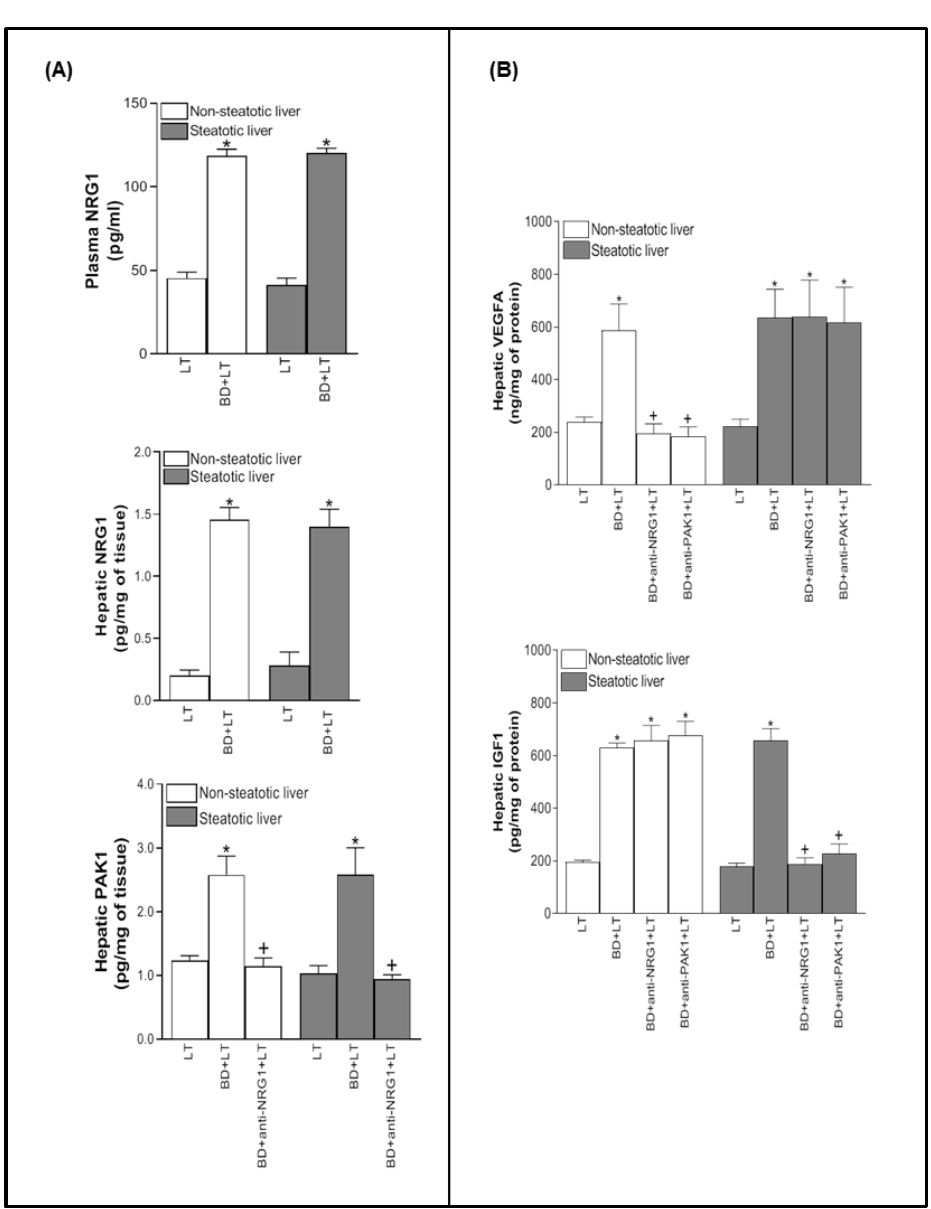
Figure 1. This is a figure. Schemes follow. Effect of NRG1 on PAK1, IGF1, and VEGFA levels in steatotic and non-steatotic LT from DBDs in a genetic obesity model. ( A ) Levels of NRG1 in plasma and levels of NRG1 and PAK1 in liver tissue. ( B ) Levels of IGF1 and VEGFA in liver tissue. * p < 0.05 vs. LT; + p < 0.05 vs. BD+LT.